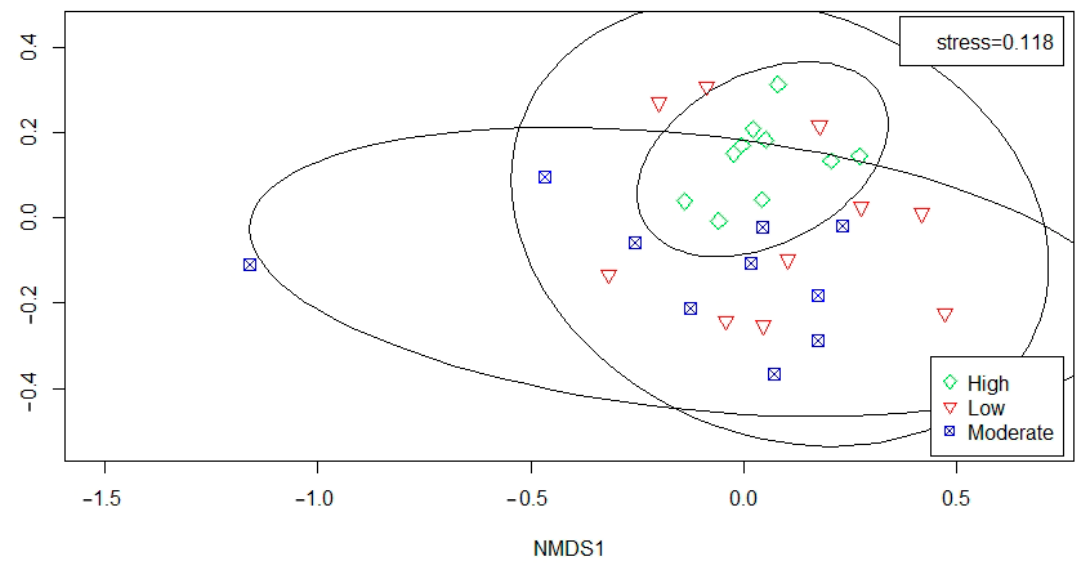
Figure 6. NMDS two-dimensional plot of bird assemblages from 30 sampled sites. The ellipse indicates the 95% confidence interval for each disturbance level.